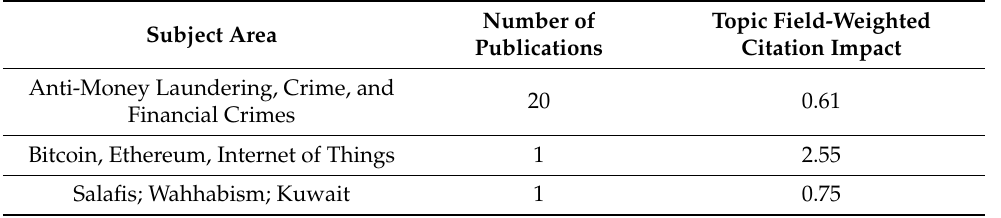
Table 4. Scholarly Contribution of Naheem, 2017–2021.